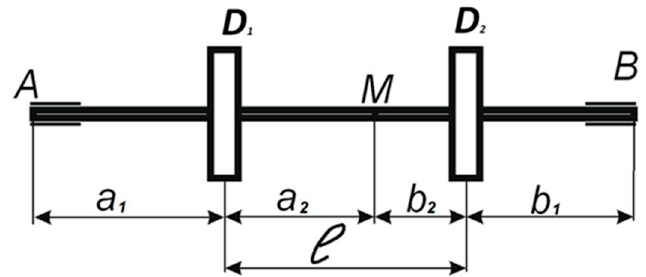
Figure 2. Diagram of a rod string with two reduced discs D 1 and D 2 .